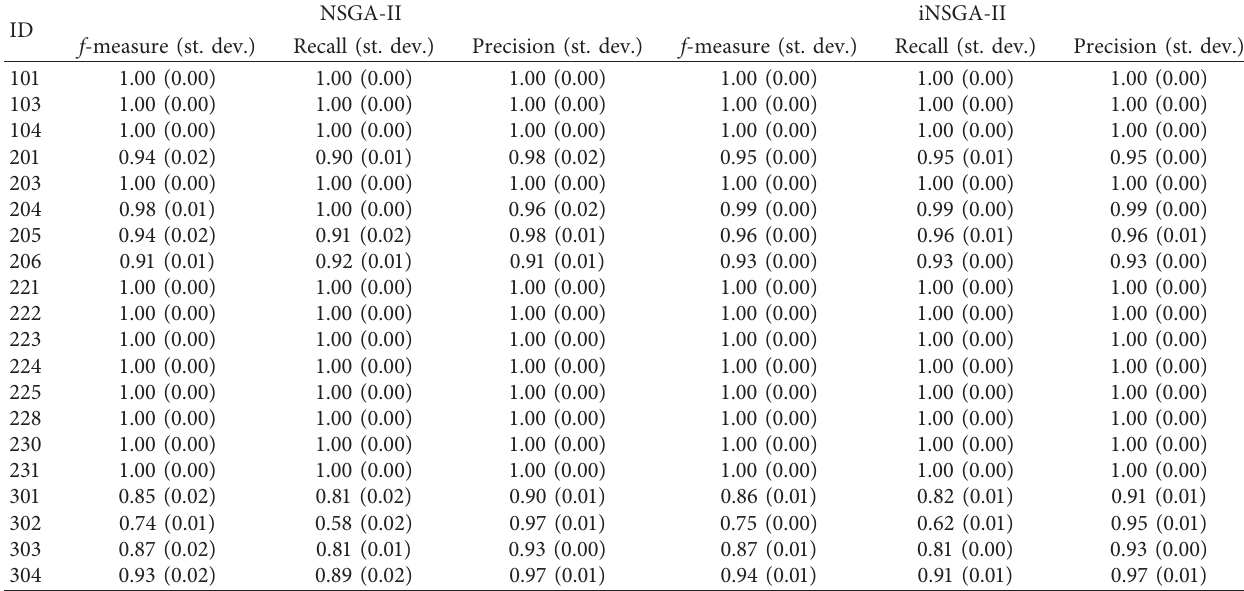
Table 2: Comparison of the f -measure, recall, and precision obtained by iNSGA-II and NSGA-II through the mean value and standard deviation. f -measure (st. dev.)